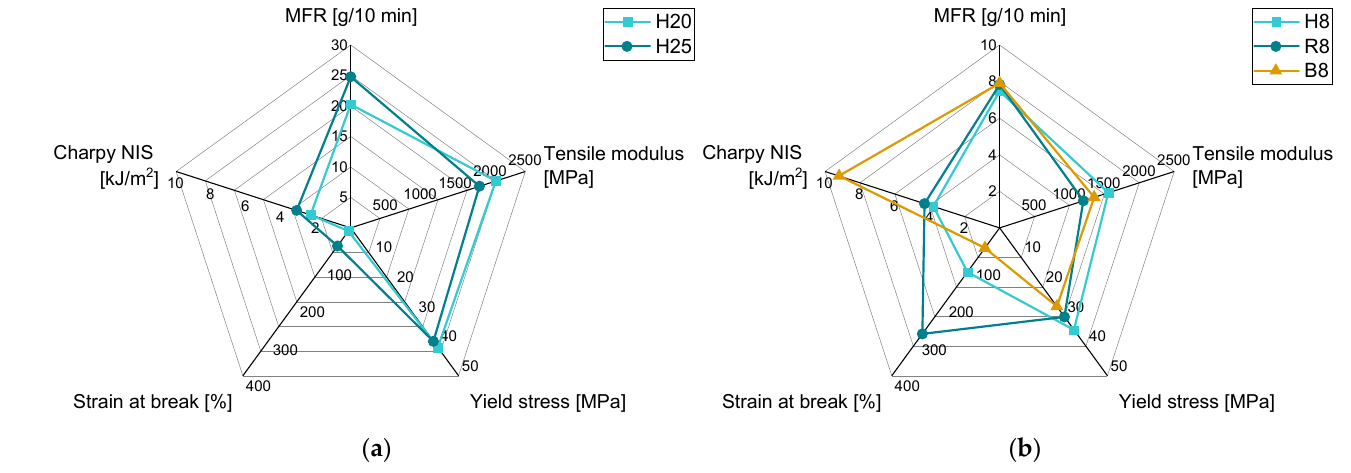
Figure 3 . MFR and mechanical properties of ( a ) H20 and H25 and ( b ) H8, R8, and B8. Figure 3. MFR and mechanical properties of ( a ) H20 and H25 and ( b ) H8, R8, and